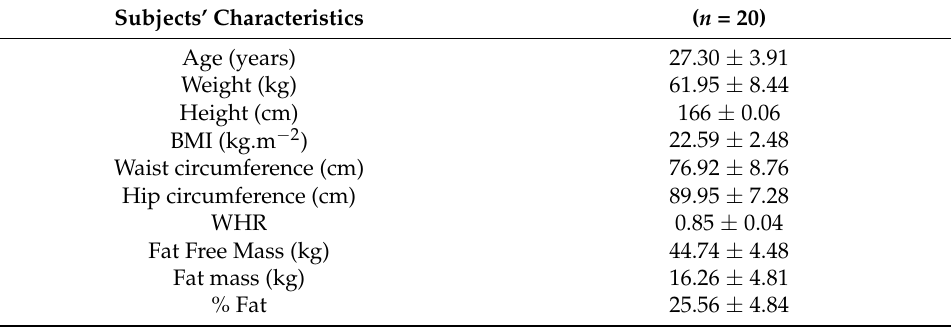
Table 1. The characteristics of the